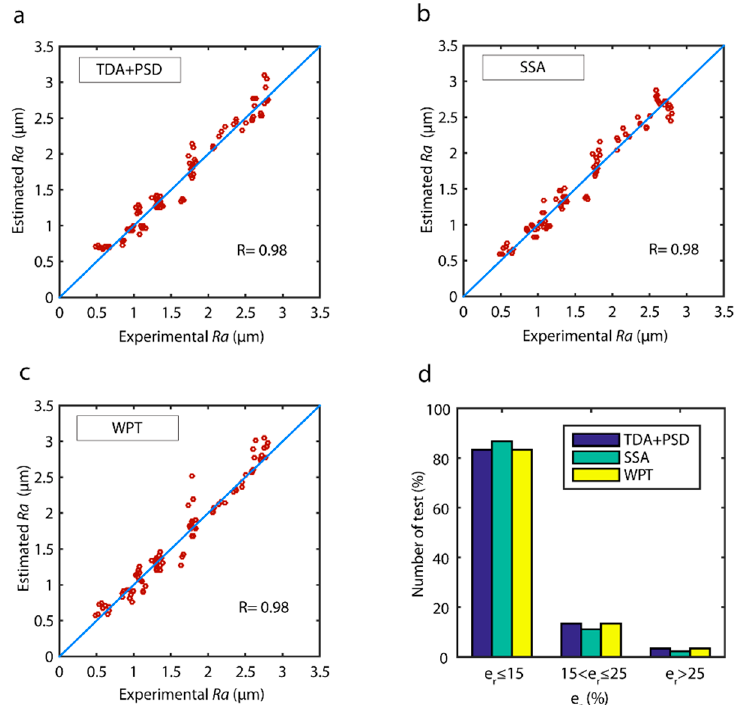
Figure 21. Correlation of estimated data versus validation experimental data obtained with ANN predictive model and multi-sensor data fusion: ( a ) TDA + PSD, ( b ) SSA, and ( c ) WPT methods. ( d ) Prediction reliability with the ANN model.